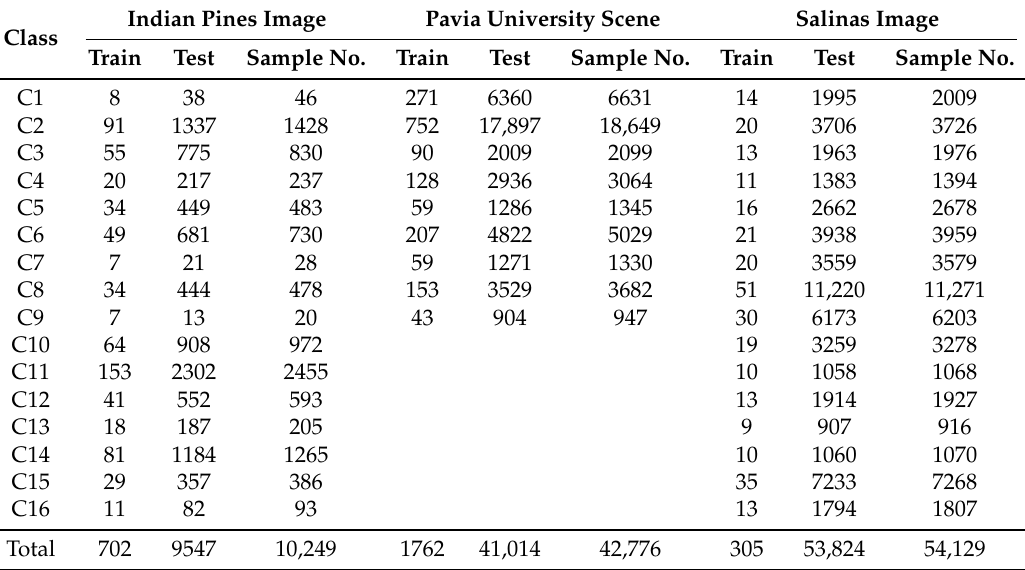
Table 1. Training and testing samples for the three hyperspectral